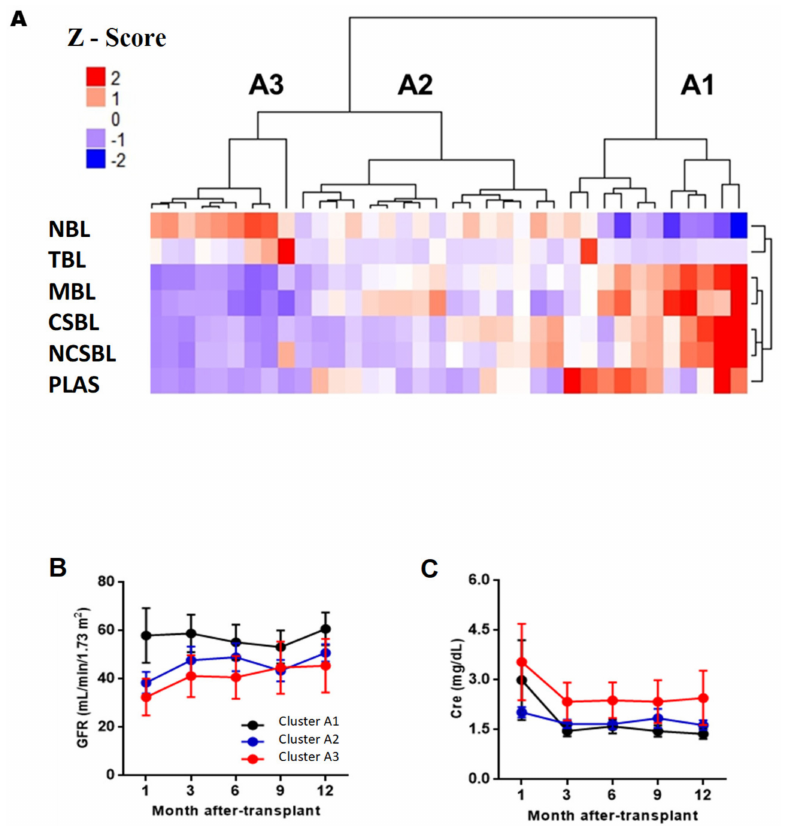
Figure 3. Analysis of BL clusters at pre-transplantation and evolution of the estimated glomerular filtration rate and Cre. ( A ) Heatmap, where they represent a matrix in which the rows are the BL subpopulations and the columns the RTRs. The color grading represents the normalized values (Z-Score) obtained for each subpopulation. Evolution of the estimated glomerular filtration levels (GFR) ( B ) and serum creatinine (Cre) ( C ) during the first year after transplantation of each cluster. The FG and Cre values at each time were compared between the clusters using the Kruskal–Wallis test and Dunn’s posthoc test with Bonferroni correction for multiple comparisons. p < 0.05 were statistically significant. Abbreviations: NBL, Naive B Lymphocytes; TBL, Transitional B Lymphocytes; MBL, Memory B Lymphocytes, CSBL, Class-Switched B Lymphocytes; PLAS, Plasmablasts; NCSBL, No Class-Switched B Lymphocytes, ZBL, Zone B